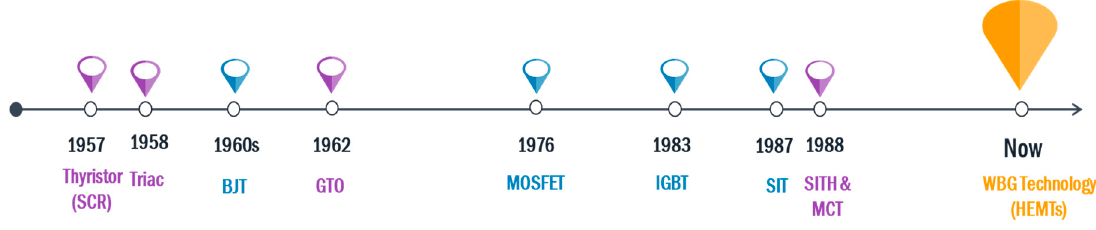
Figure 1. Time line of the introduction of modern power electronic switches.